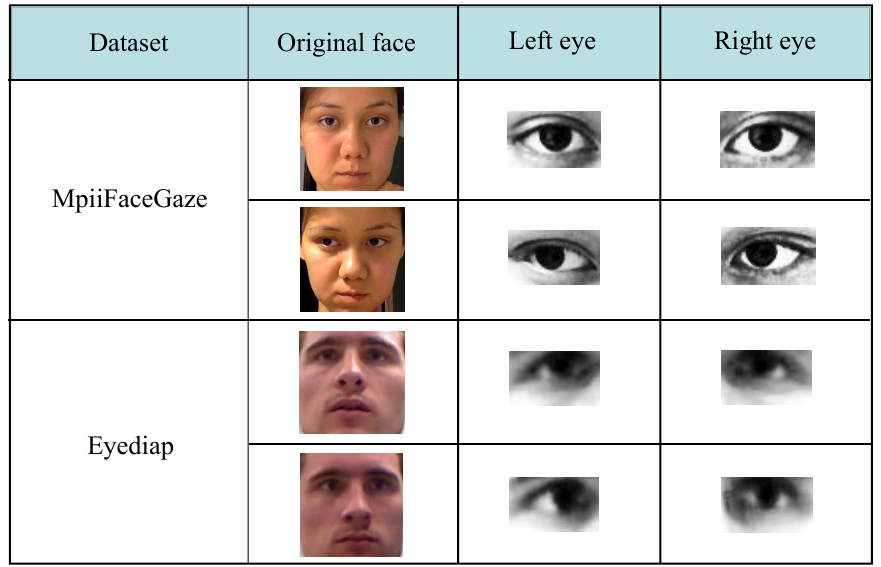
Figure 7. Example face images and their corresponding left eye and right eye images on two public